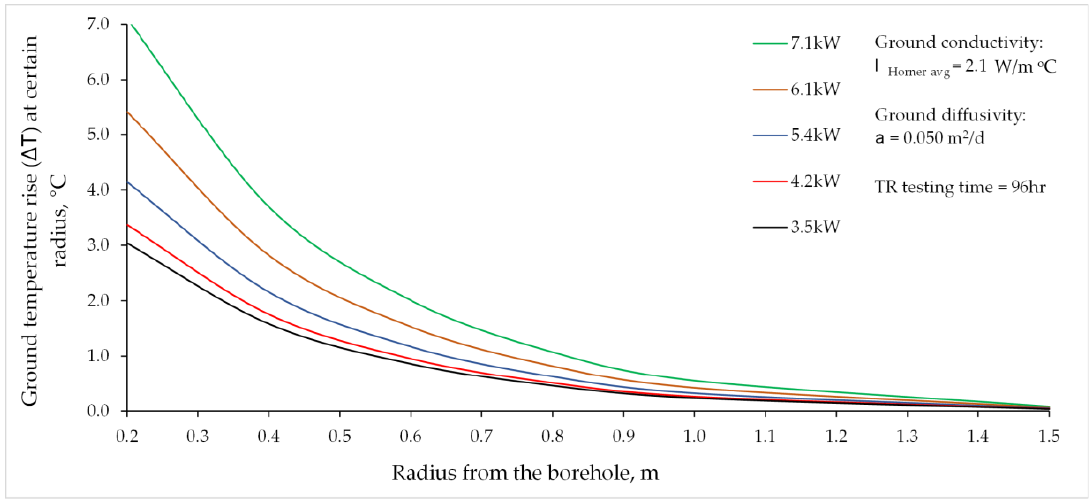
Figure 10. Ground temperature rise at a certain radius from the borehole for five different TRT heat steps.